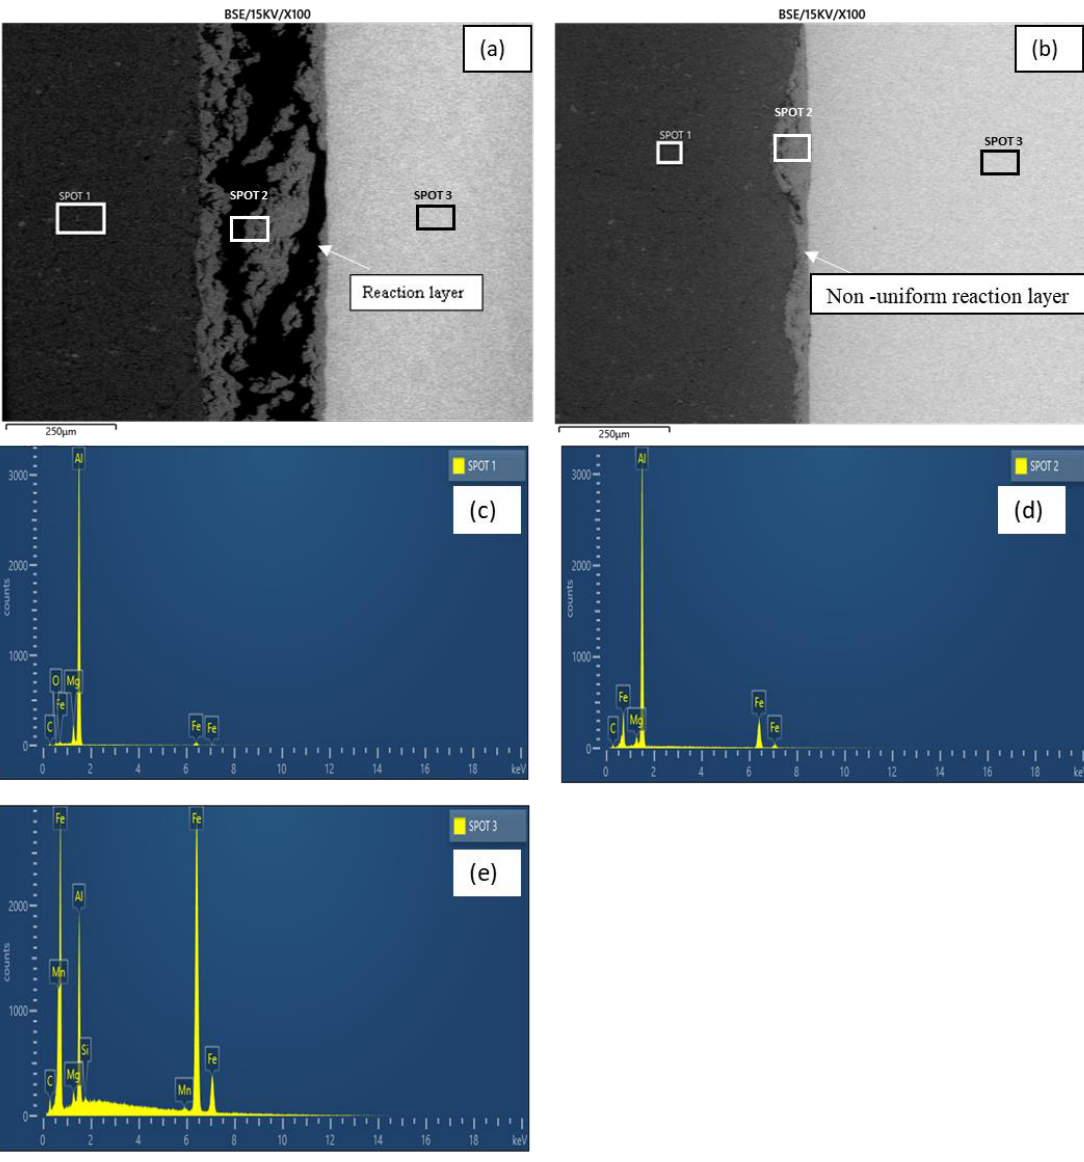
Figure 10. Elemental mapping of Gallium across the bonded metals: ( a ) Sample E and ( b ) Sample G.